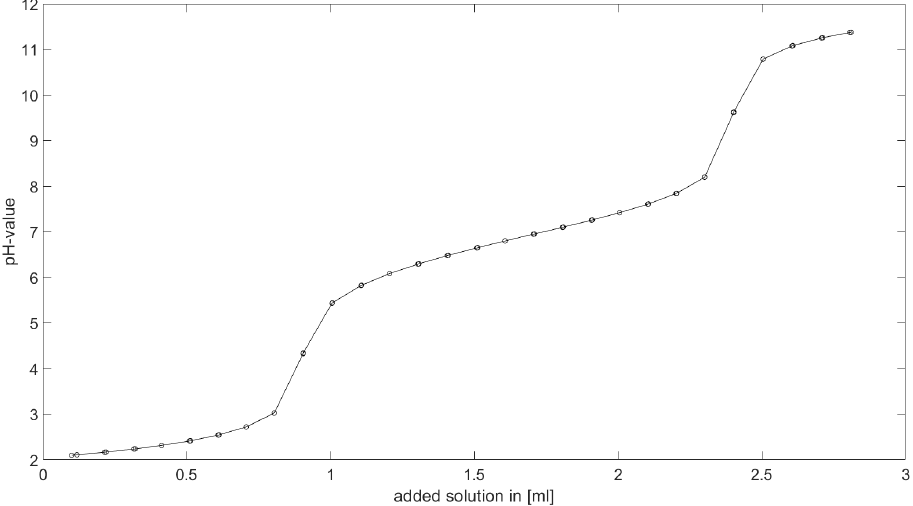
Figure 6. Calculated titration curve with complexes and stability constants as defined in Table